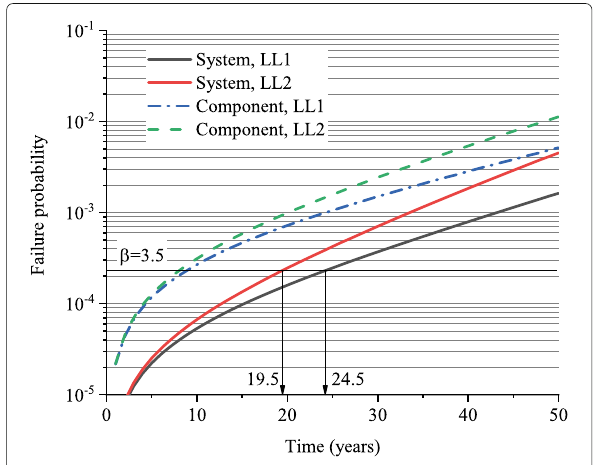
Fig. 2 Time-dependent failure probabilities of a 4-out-of-5 system and a single component